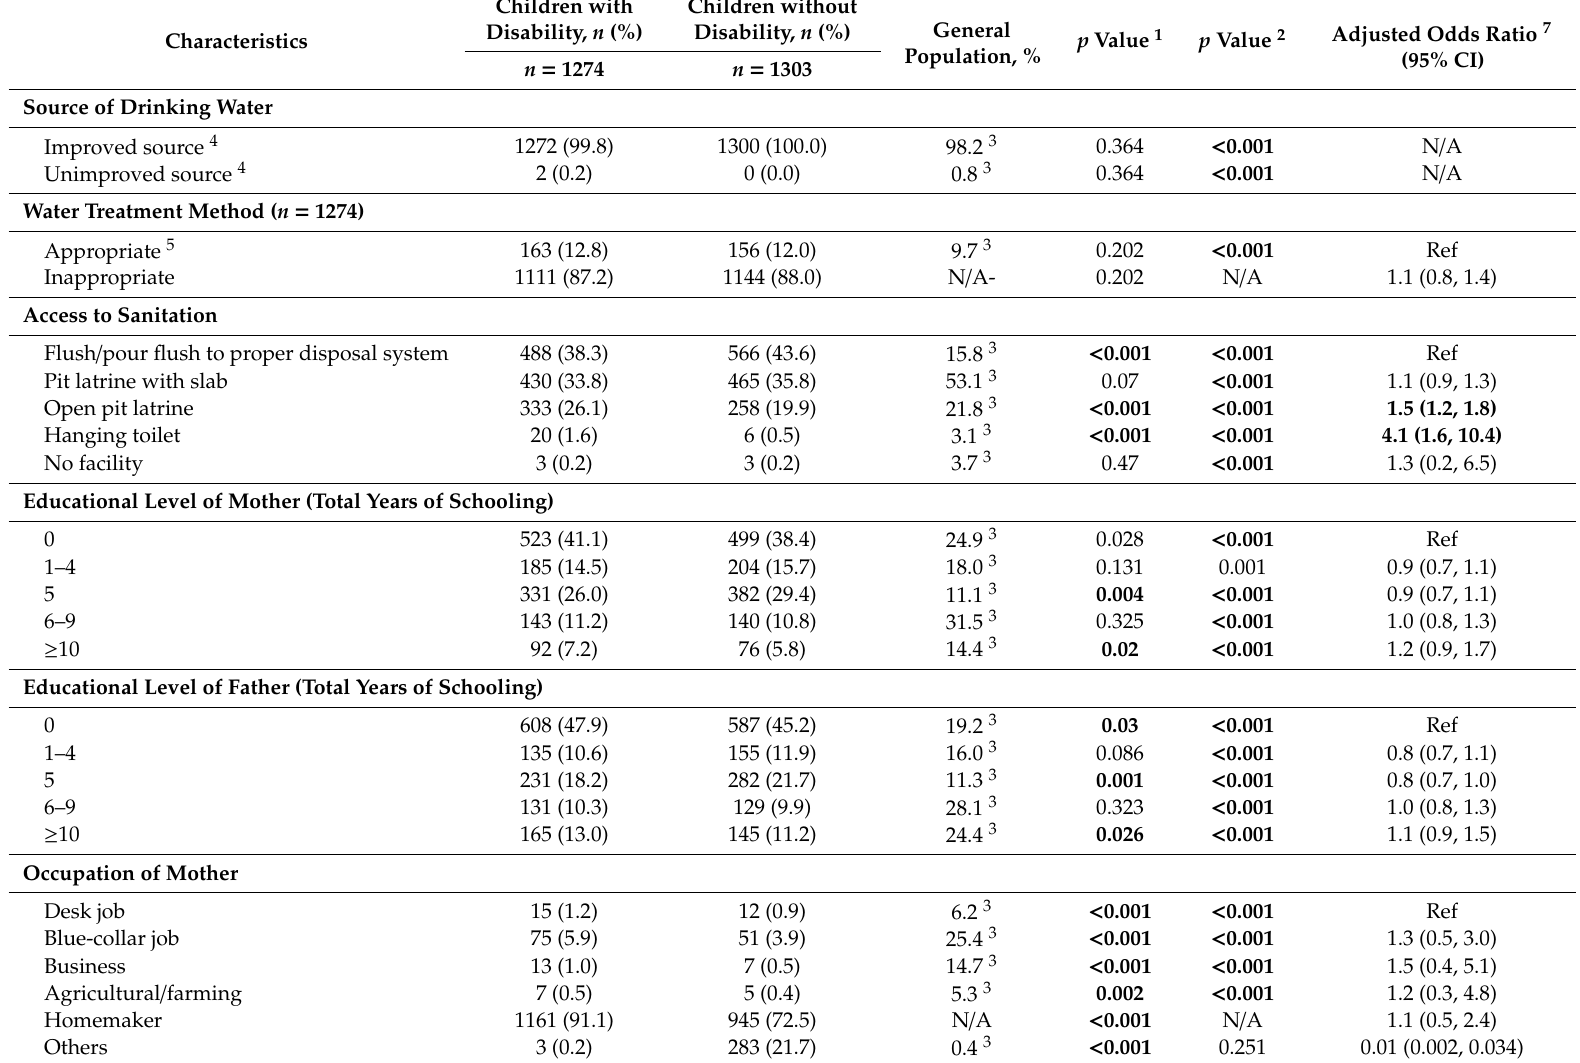
Table 2. Relationship between disability and socioeconomic